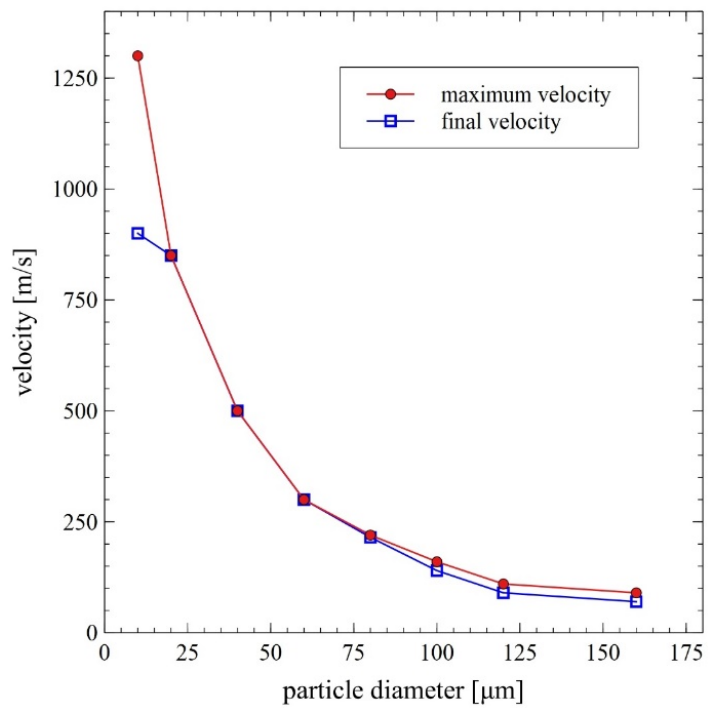
Figure 8. Maximum and final (at the base surface, i.e., water level) particle velocity as a function of its diameter—results of the DGS multiphase flow numerical modeling [14] .